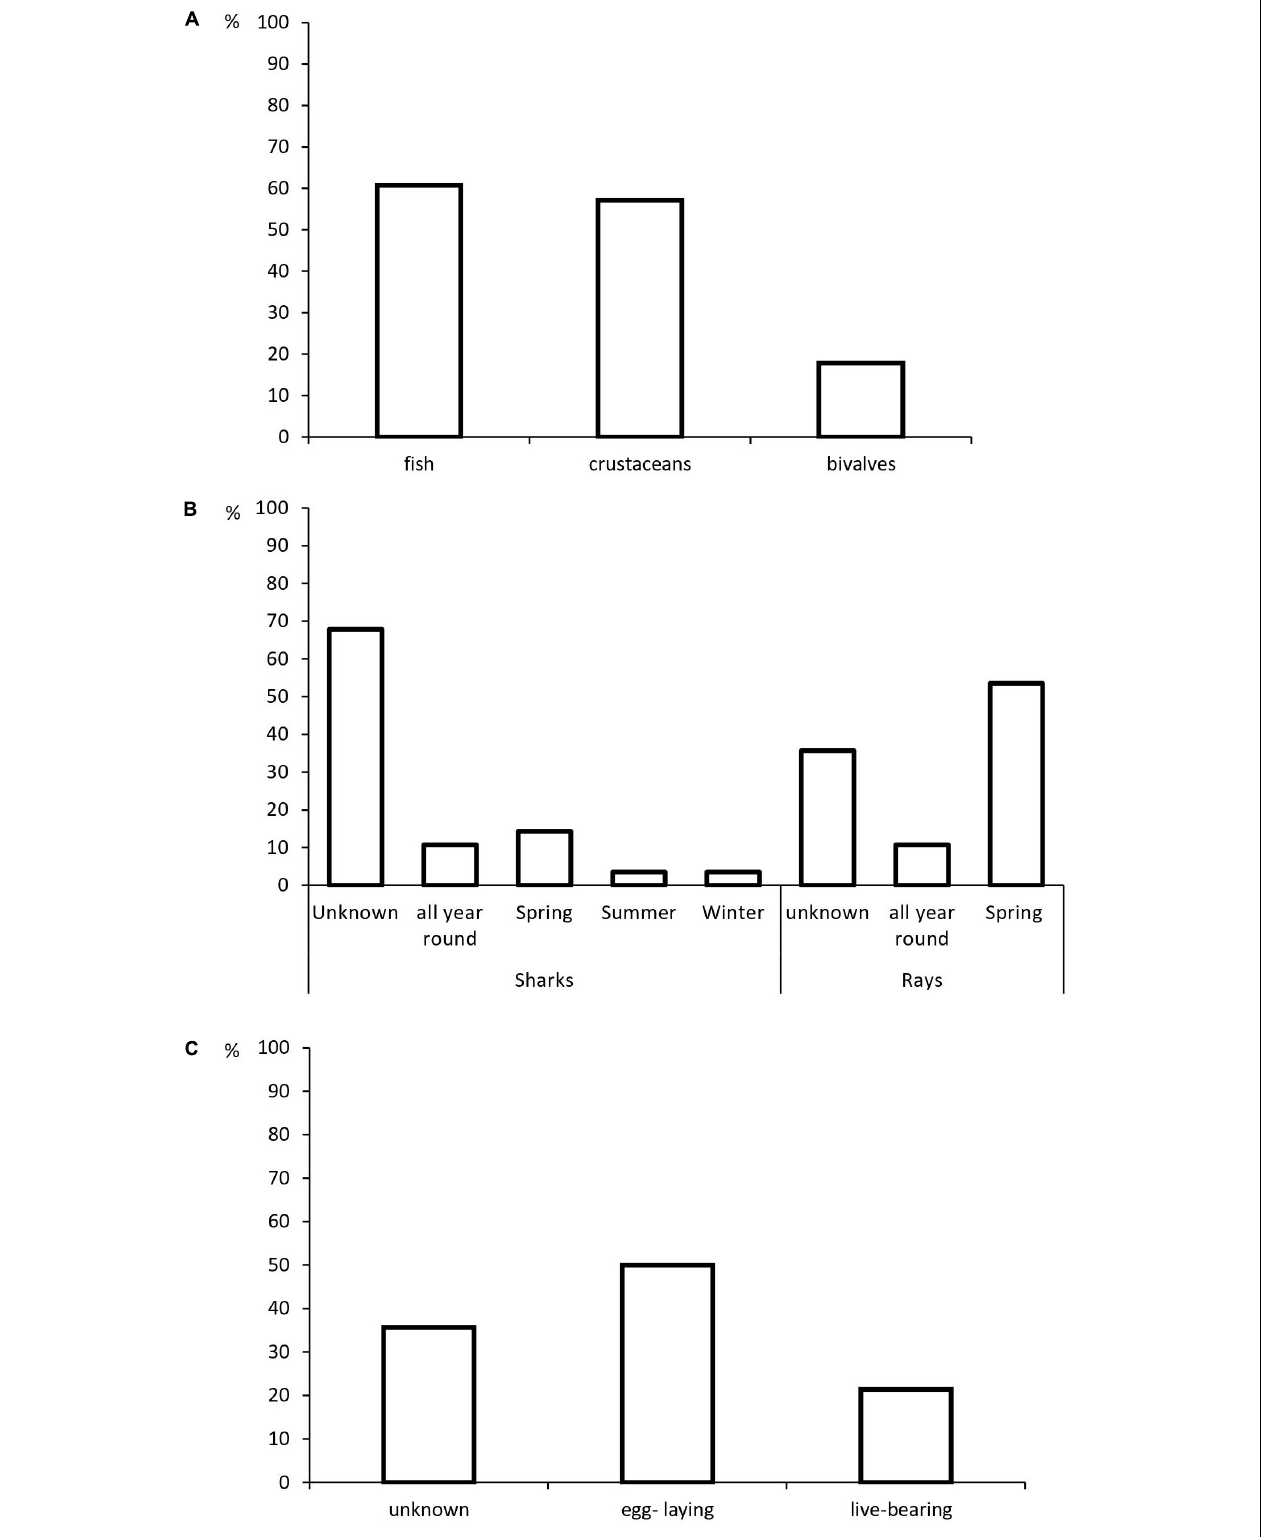
FIGURE 3 | Fishers’ knowledge about elasmobranch feeding habits (A) , reproduction season (B) and method (C) . Answers were presented as percentages. Some fishers selected more than one option in (A,B) as such values add-up to more than 100%.